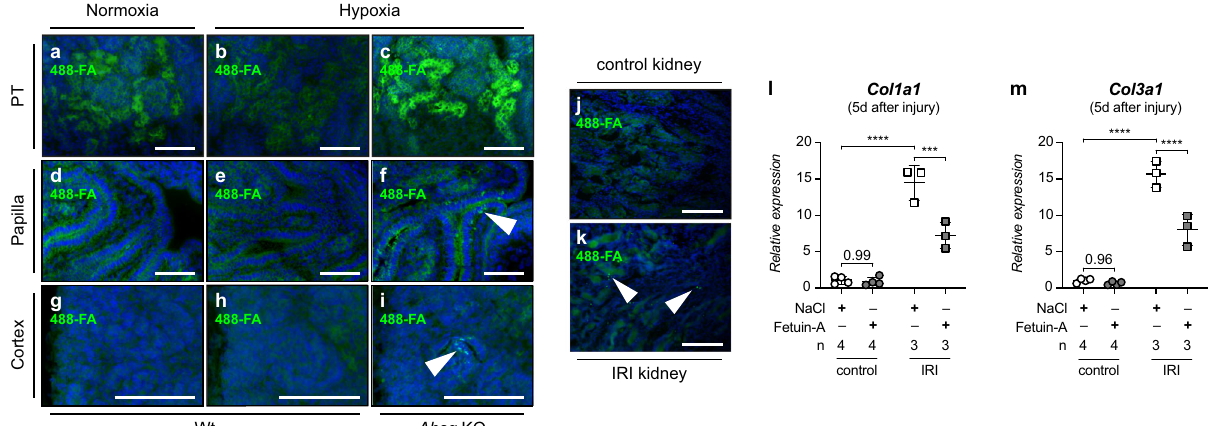
Fig. 8 Fetuin-A supplementation reduces the expression of fi brotic markers upon hypoxia-related injury. a – i Fetuin-A de fi ciency promotes accumulation of calcium mineral particles in hypoxic fetal kidneys. Calcium biominerals were detected by ATTO 488 fl uorescently labeled fetuin-A (488-FA). Compared to normoxic or hypoxic wt mice, hypoxic Ahsg KO mice exhibited the strongest 488-FA staining intensity in the proximal tubulus (PT), indicative of an increased mineralized matrix turnover ( a – c ). Arrowheads in f and i point towards granular staining pattern in the papilla and cortex, respectively, re fl ecting bulk accumulation of 488-FA in kidneys of hypoxic Ahsg KOs. Such granules were not detectable in wt samples ( d , e , g , h ). j , k Ischemia-reperfusion injury (IRI) induces calcium mineral particles in adult kidneys. A granular staining pattern indicative of bulk accumulation of 488-FA at sites of calcium deposits was only present in IRI kidneys ( k ), but not in controls ( j ). l , m Fetuin-A supplementation reduced the expression of the fi brotic markers Col1a1 ( l ) and Col3a1 ( m ) in IRI kidneys 5 days after injury. No effect is seen in mice treated with physiological saline solution (NaCl). Data were analyzed from N = kidneys and are presented as mean ± SEM. Ordinary one-way ANOVA with Dunnett ’ s multiple comparisons test. Individual P -values are denoted above the comparison lines. (**** P < 0.0001; *** P < 0.001). Images are representative of at least three independent experiments ( a – k ). Scale bar = 100 µ m ( a – k ). Source data are provided as a Source Data fi